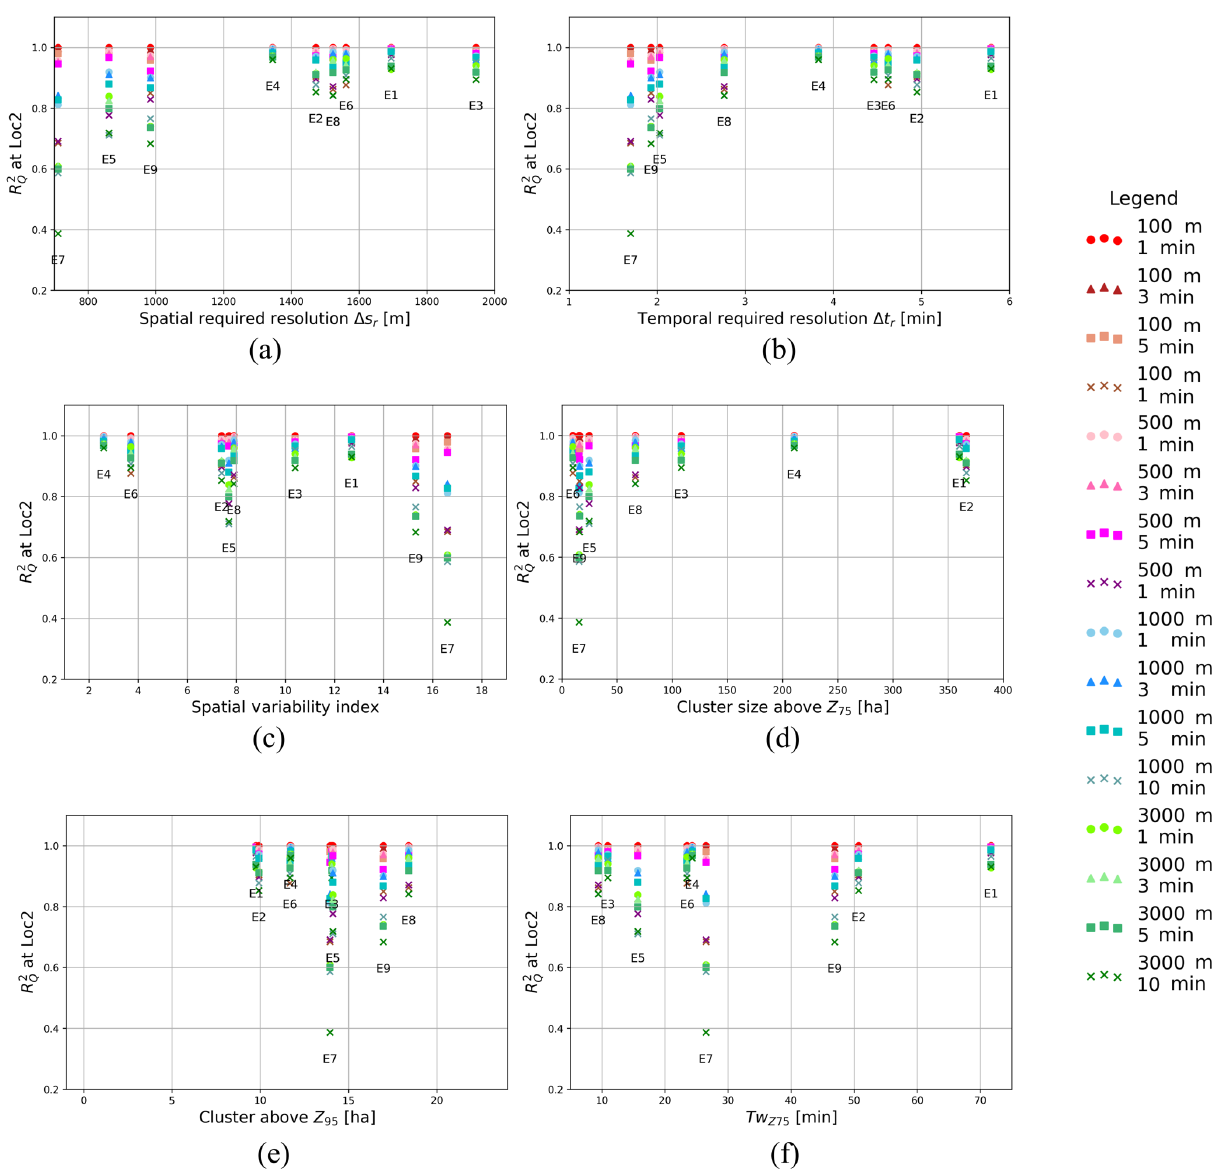
Figure 9. R 2 at Loc2 for different rainfall resolution, plotted against different rainfall characterizing scales: spatial (a) and temporal (b) re- Q quired resolution, spatial variability index (c) , dimension of cluster above Z 75 (d) and Z 95 (e) , and maximum wet period above Z 75 (f)